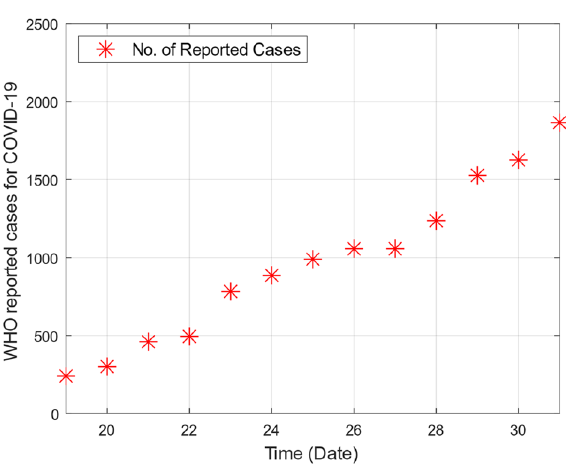
Figure 5. Comparative bar chart and line plot of reported deaths and recovered individuals of COVID-19.